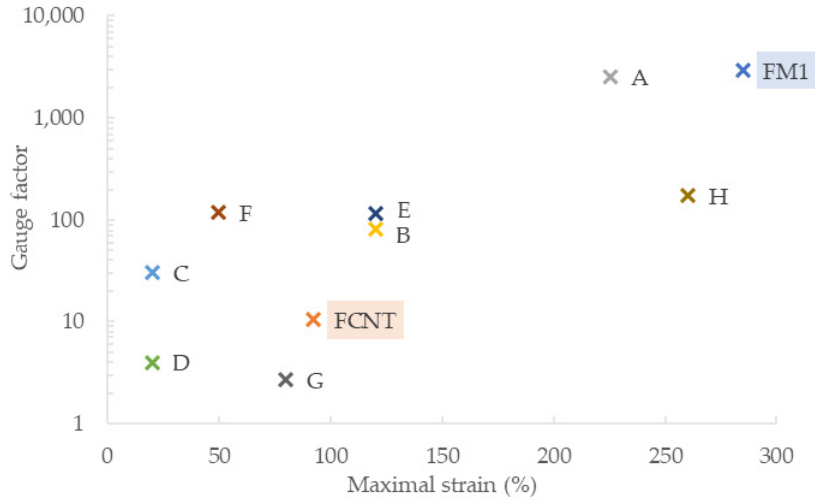
Figure 7. Comparison with previous works on piezoresistive composites based on carbon fillers and polymers from the styrene-butadiene family. Corresponding notation can be found in Table 3.